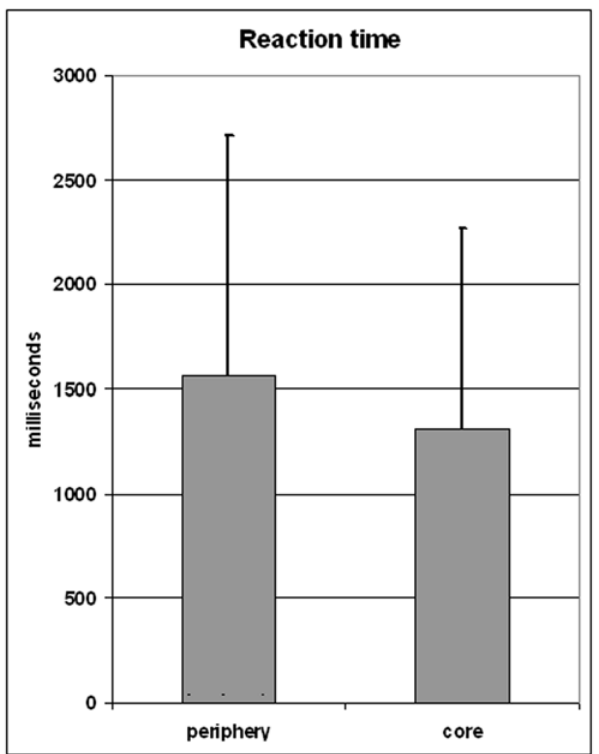
Figure 4. Effect of region on reaction time. Vertical : reaction time in milliseconds. Horizontal : peripheries vs. cores. Thick bars: Mean reaction time, determined for the whole group. Thin bars : standard error.